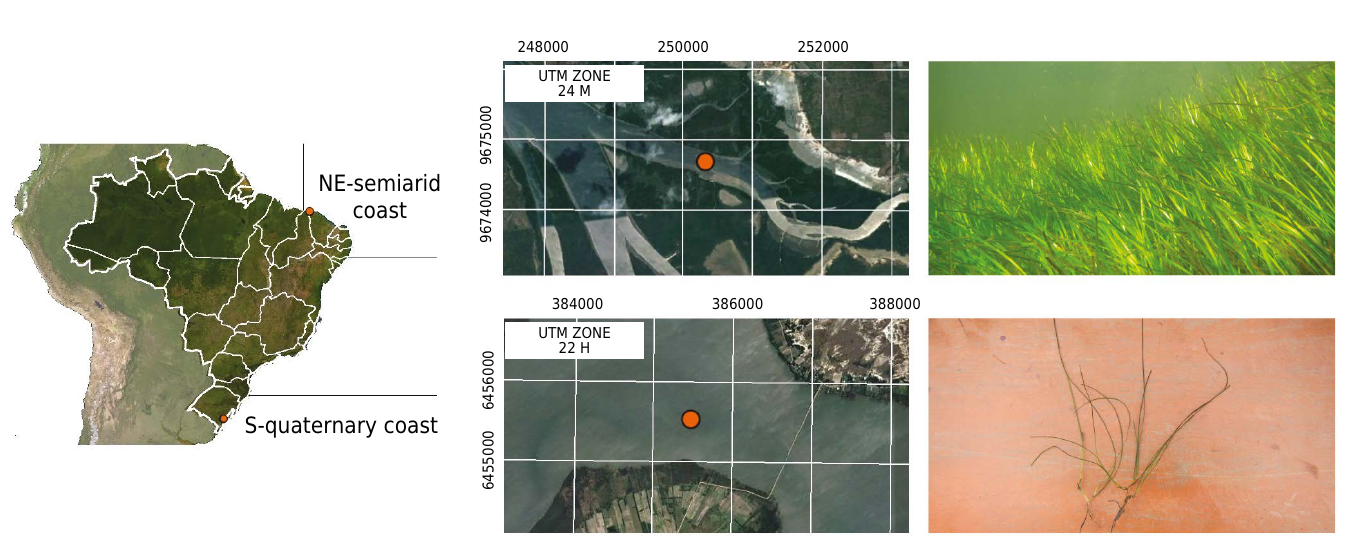
Figure 1. Subaqueous soil sampling locations.